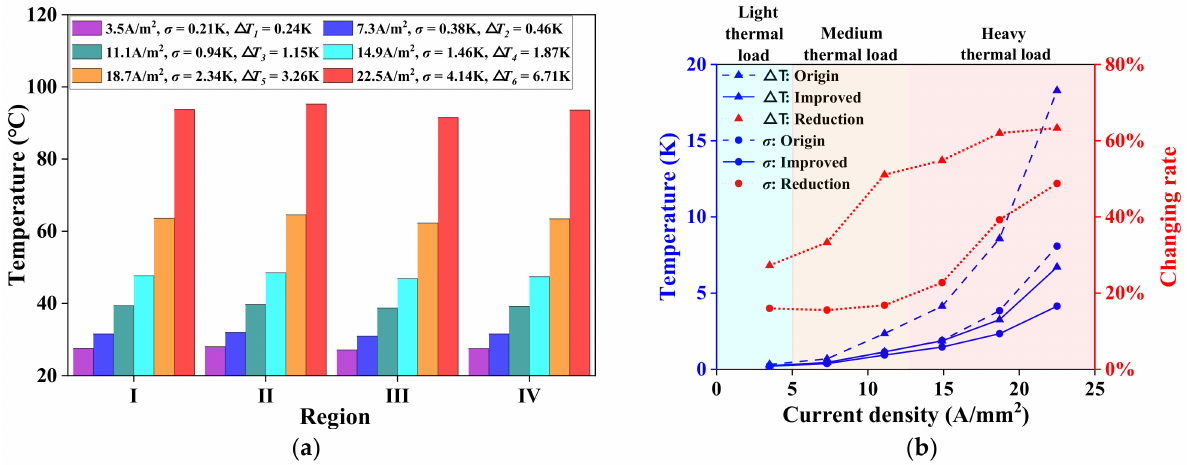
Figure 18. Current density effect on temperature distribution. ( a ) Winding temperature distribu- tion for the improved specimen under a wind velocity of 4.7 m/s and different current densities (3.5 A/mm 2 , 7.3 A/mm 2 , 11.1 A/mm 2 , 14.9 A/mm 2 , 18.7 A/mm 2 and 22.5 A/mm 2 ). ( b ) Comparison of (cid:52) T and σ between the original and improved specimens under typical current density intervals corresponding to common cooling methods.